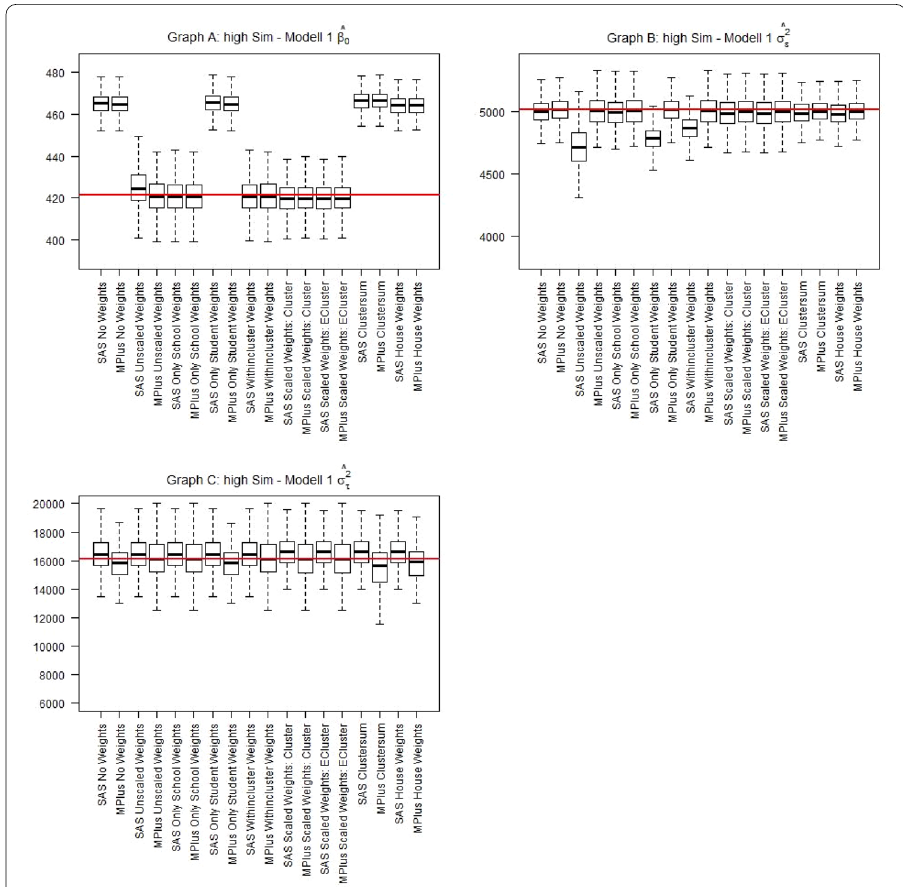
Fig. 3 Simulation outcomes for data reflecting high variances between schools. Model 1 is declared as y ij = β 0 + τ i + ε ij , Model 2 as y ij = β 0 + β 1 ∗ x ij + τ i + ε ij and Model 3 as y for each estimate are marked as red line. Simulation variation is displayed with the different weighting approaches combined with different estimation algorithms implemented in the two examined